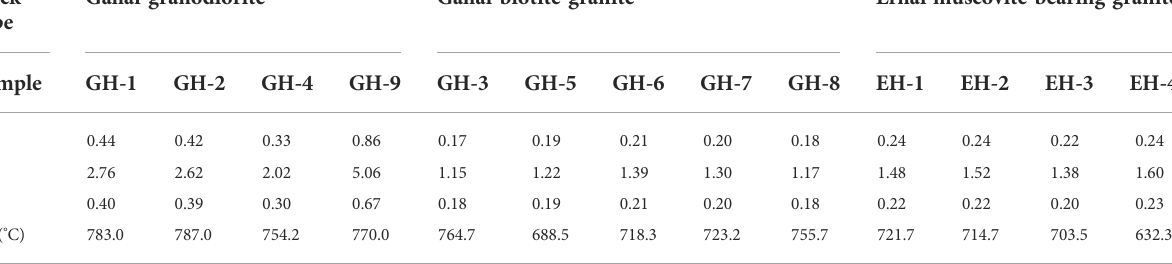
(Figure 6). On the La/Yb – Yb discrimination diagram, samples